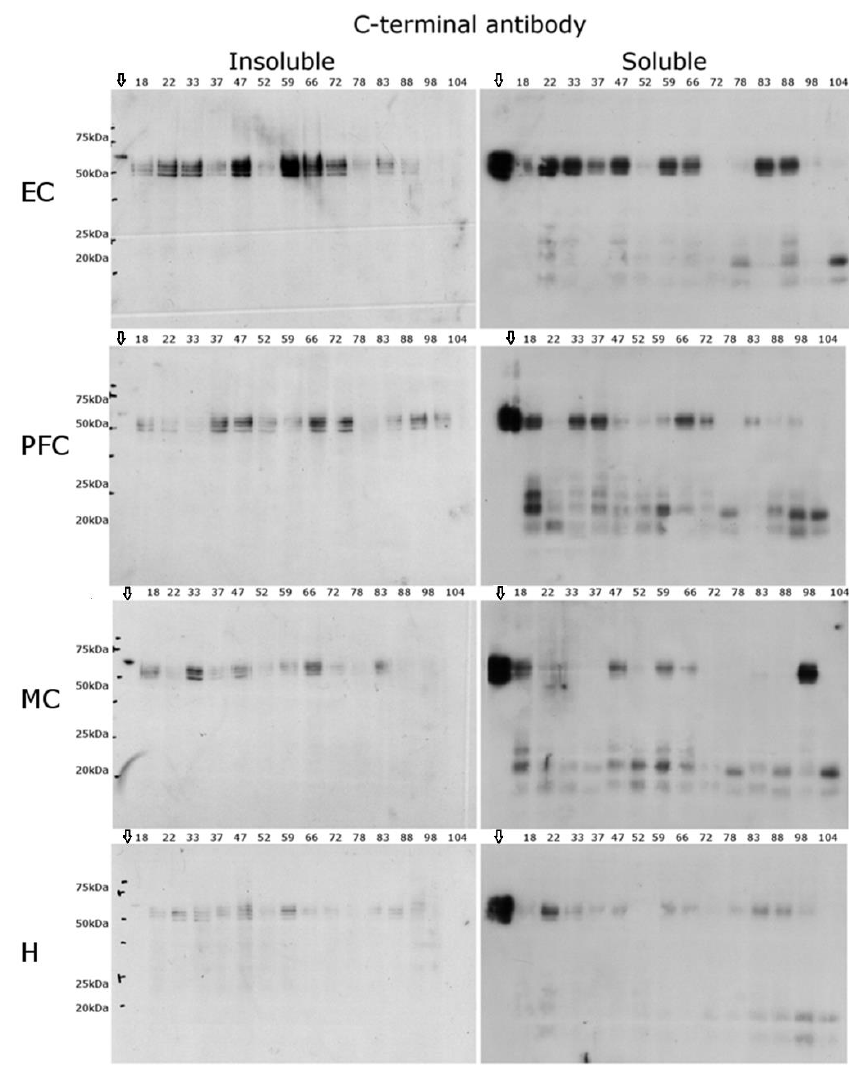
Figure 5. Soluble and insoluble fractions from the same brain regions using a C-terminal Tau antibody. Western blot analysis of the C-terminus of Tau. Both insoluble and soluble fractions were probed with an antibody specific to the C-terminus of Tau in four brain regions: the entorhinal cortex (EC), prefrontal cortex (PFC), motor cortex (MC), and hippocampus (H). The ages are displayed above each lane. Downward arrow Tau 6 ladder standard loaded onto each gel. The cerebellum is not shown due to the lack of immunoreactivity in this region.